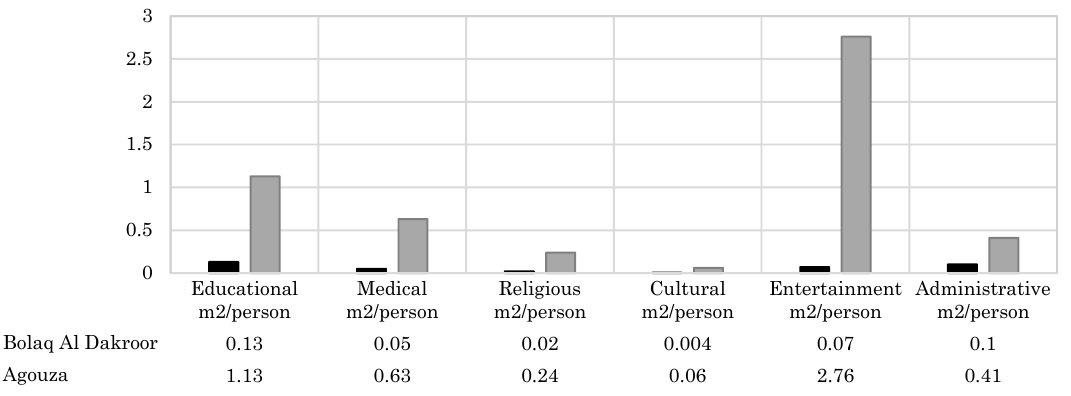
Figure 5. Shows land ‐ use in Agouza.